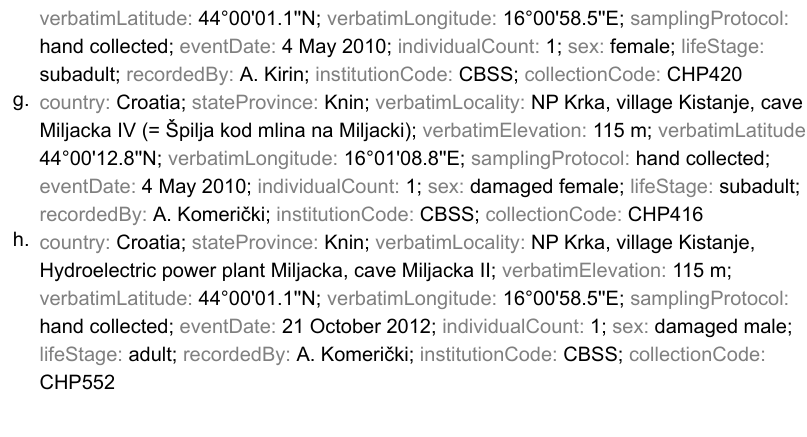
Description of holotype: Body length: approx. 30 mm (measured from anterior margin of cephalic plate to posterior margin of telson); leg 15 – 22.6 mm long, or 75% length of body. Color: uniformly yellow-brownish to chestnut, margins of cephalic plate slightly darker than inner parts (Fig. 1).